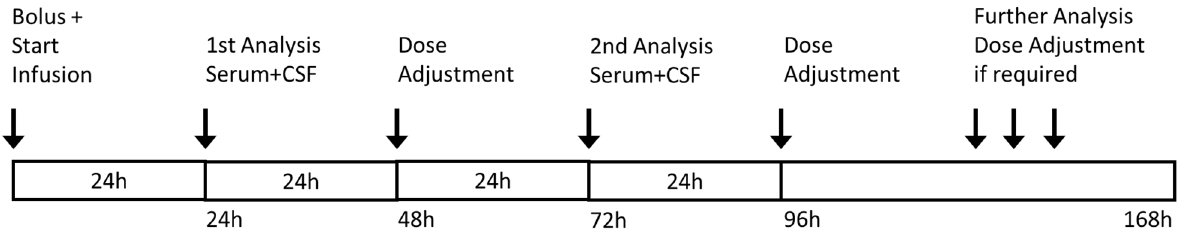
Figure 6. Treatment regimen. Serum and CSF concentrations were analyzed after 24 and 72 h with consecutive dose adjustment after 48 or 96 h from the start of infusion. Further analyses and dose adjustment were only performed where necessary.